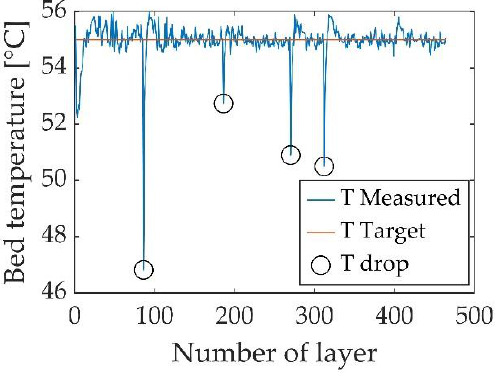
Figure 11. Bed temperature, referring to the printed layer.